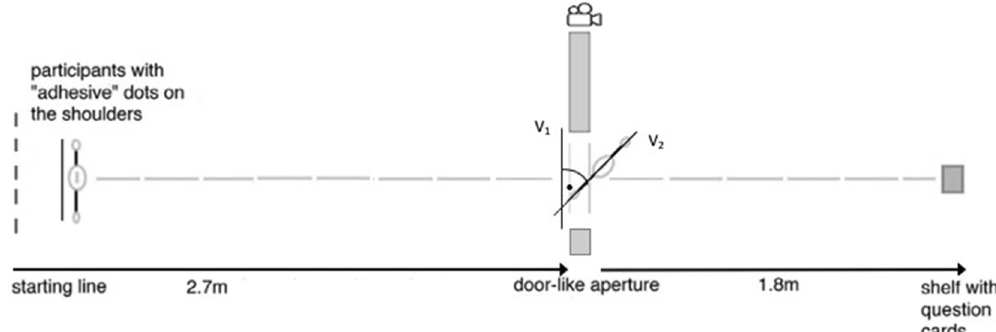
Figure 2. Schematic set up of the aperture and angle vectors to calculate shoulder rotation. Vector V2 points from the right to the left adhesive shoulder marker and vector V1 points from right to the left partition of the door aperture. Shoulder rotation was defined by calculating the angle between V1 and V2. An angle greater than 30° was defined as a